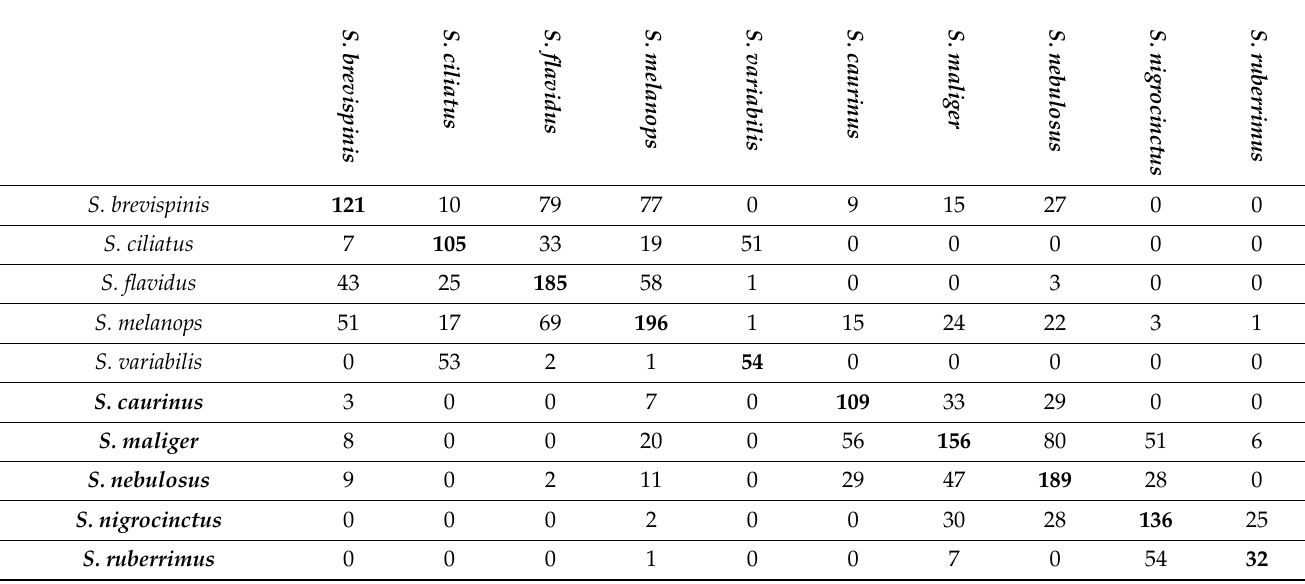
Table 5. Results from ANOVA test for δ 15 N across time for four rockfish species.